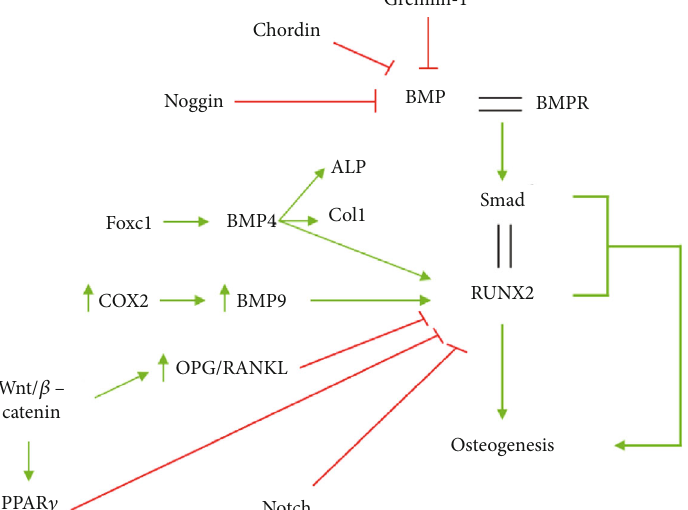
Figure 3: Illustration of how various signalling pathways regulate osteogenesis through the master regulator of osteogenesis, RUNX2. Green arrows indicate positive regulation while red lines indicate negative